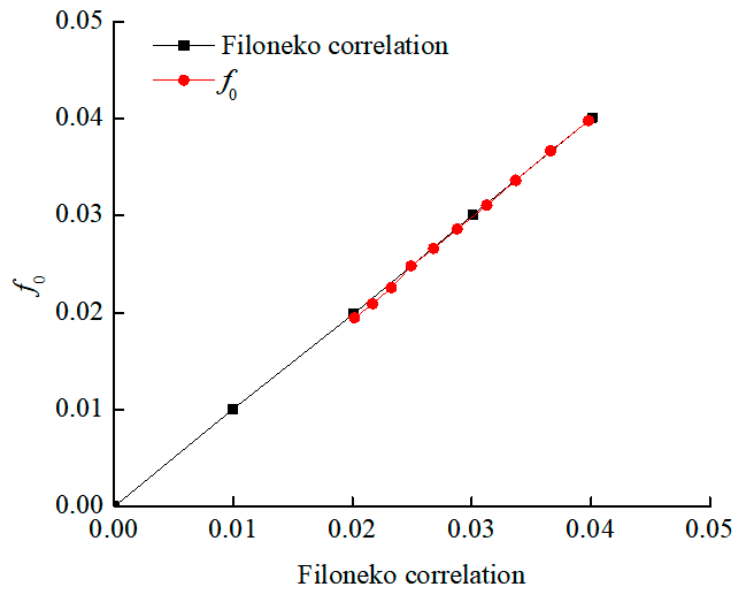
Figure 9. Comparisons of numerical results of friction factor with the data from Filonenko correlation.